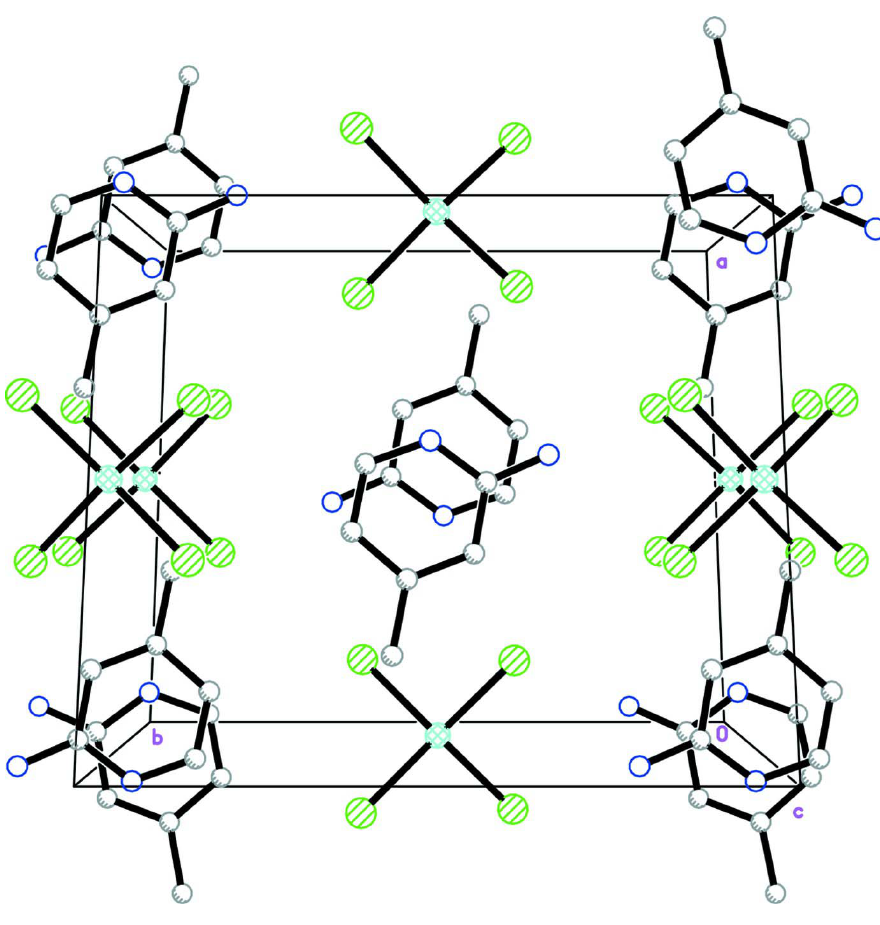
Figure 2 Crystal packing diagram showing alternating stacks of anions and chains of cations.